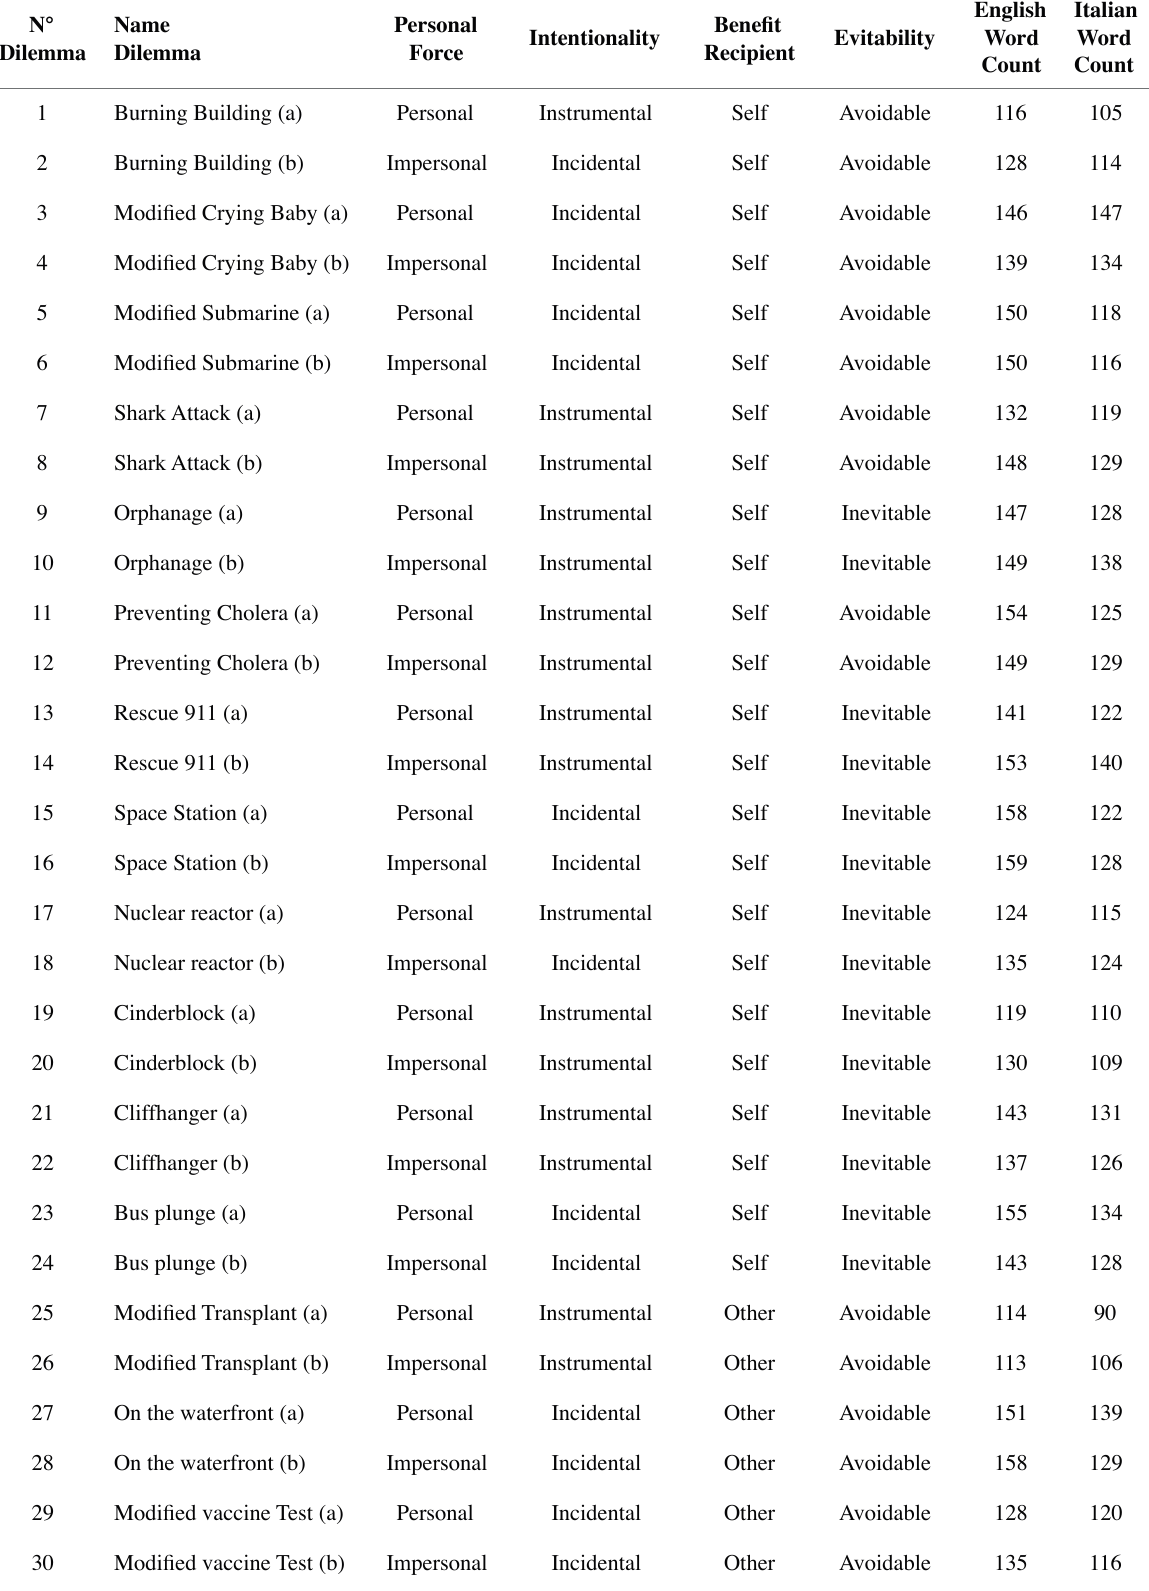
Table 1SI. Summary of